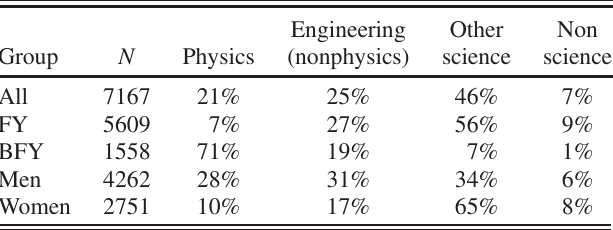
data sets ( N ¼ 7167 ). Note that the Physics category includes both physics and engineering physics majors; the Other science category includes (but is not limited to) biology, chemistry, and math majors; and Nonscience includes both declared nonscience majors and students who are open option or